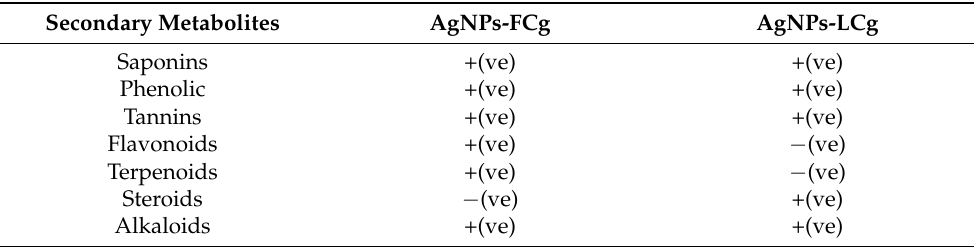
Table 1. Qualitative phytochemical analysis of AgNPs-FCg and AgNPs-LCg.